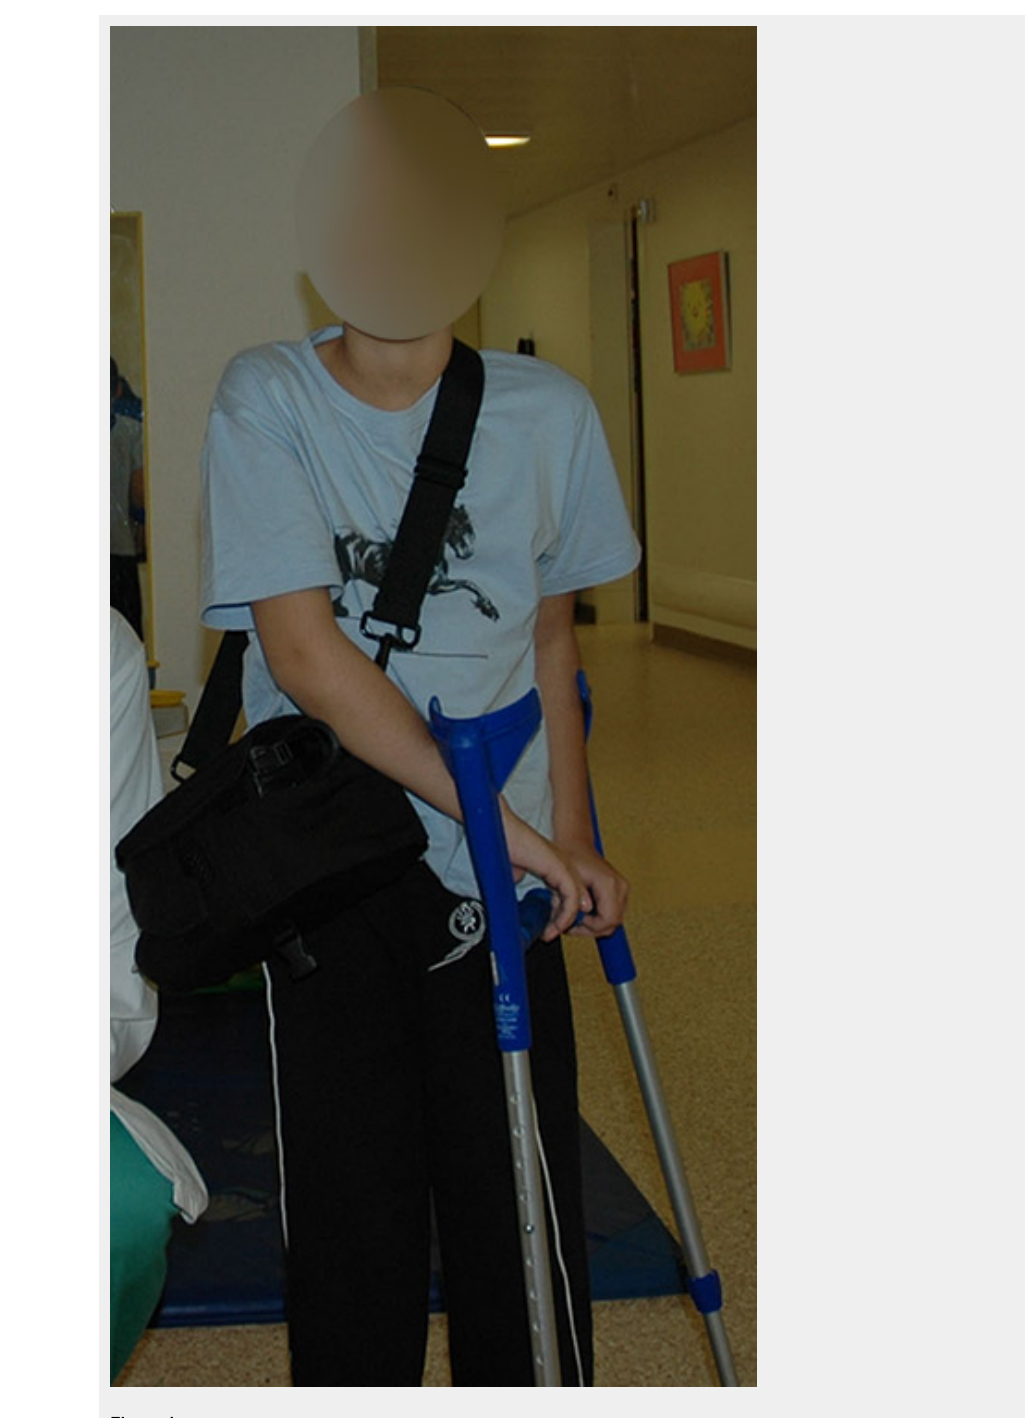
Figure 1 Eight-year old child provided with a Heartware HVAD (third-generation continuous flow device) as a bridge to